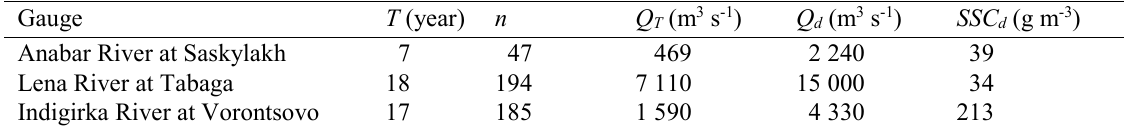
Table 2 Summary statistics for the study